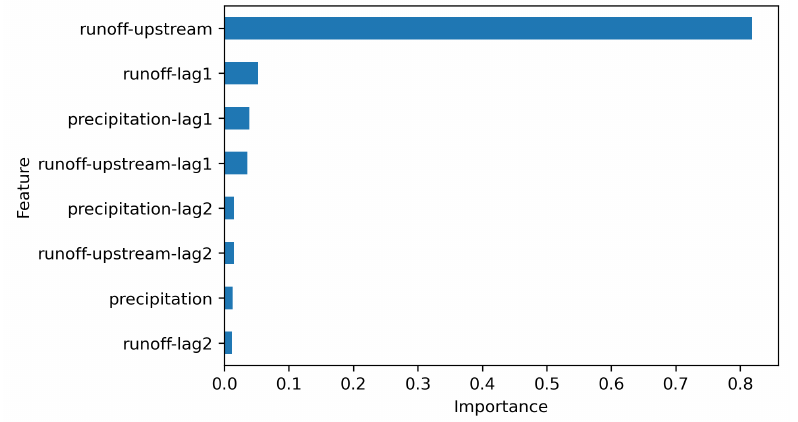
Figure 4. The XGBoost model built-in feature importance. Lag1 suffix corresponds to information from previous day, lag2 from two days ago. Runoff features are for Wadowice cross-section, while runoff-upstream for Osielec cross-section.